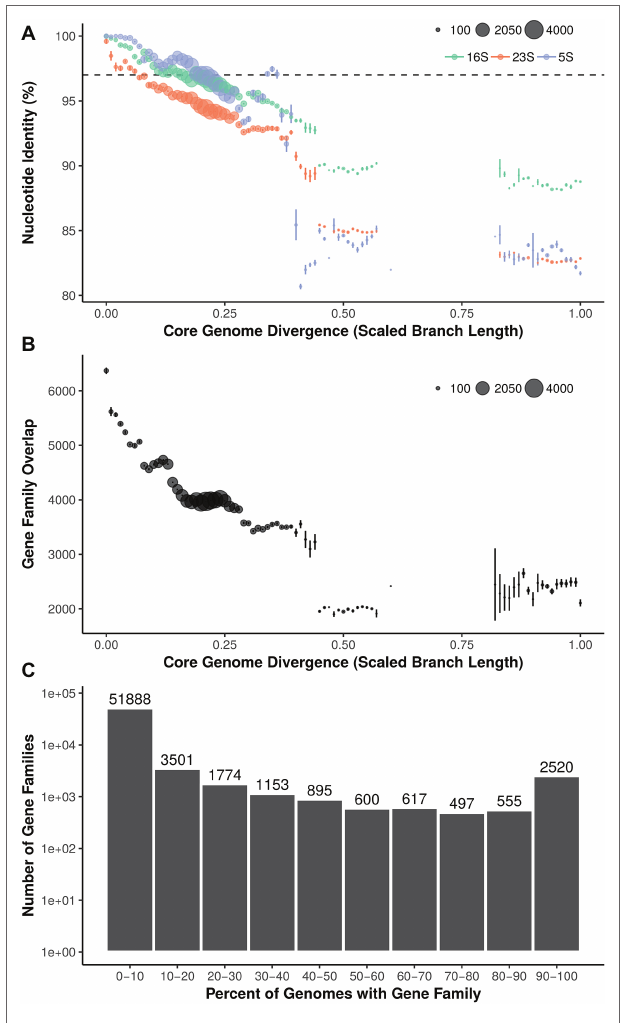
FIGURE 2 | (A) Relationship between core genome divergence and 5S, 16S, and 23S rRNA genes in Streptomyces . Dashed line = 97%; size of dot = number of pairwise comparisons. (B) Relationship between core genome divergence and shared gene families in Streptomyces . Size of dot = number of pairwise comparisons. (C) Distribution of gene families across the Streptomyces